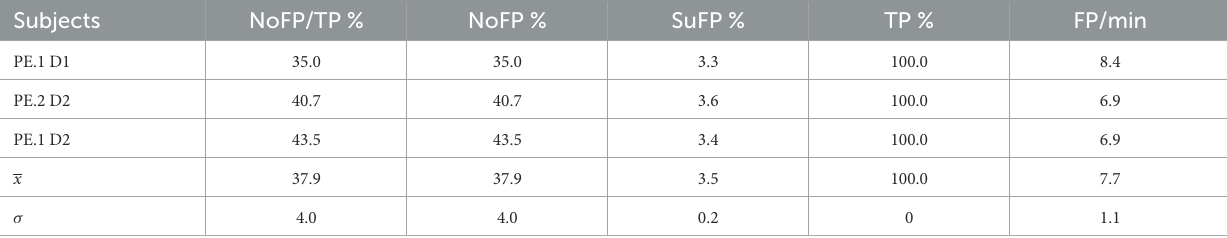
TABLE 10 Performance of the BMI working in close-loop control of the